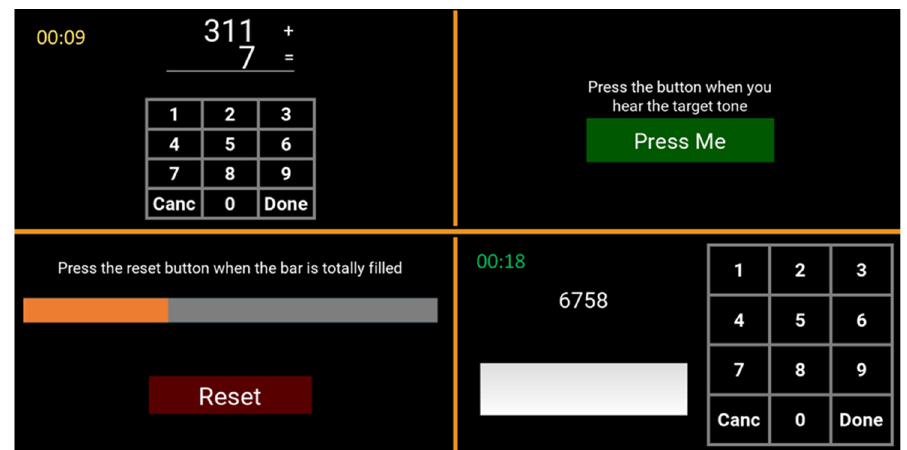
Figure 1. Multitasking application screen. In clockwise order: the auditory monitoring, the phone number entry task, the visual monitoring and the mental arithmetic task.